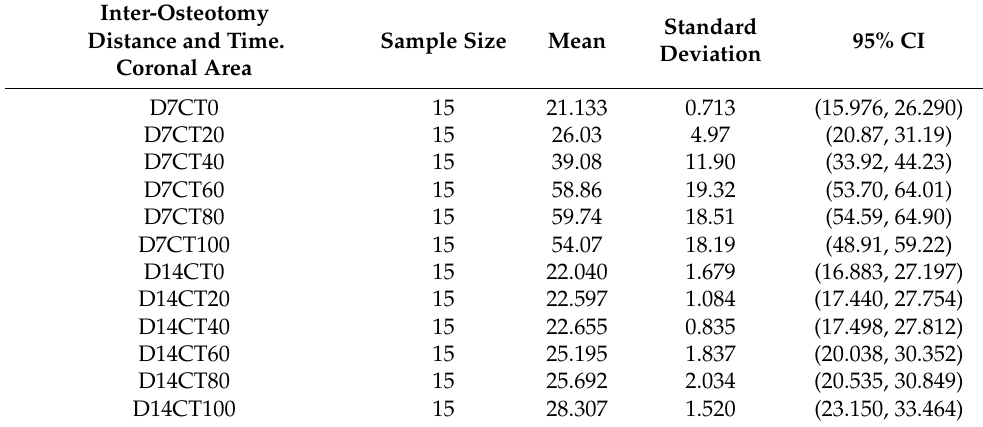
T4 = 80 s, T5 = 100 s).